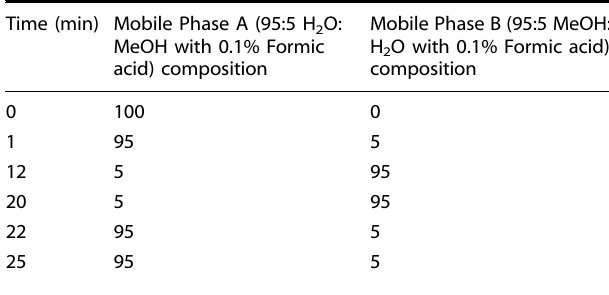
Table 5. Mobile phases and gradient elution pro fi